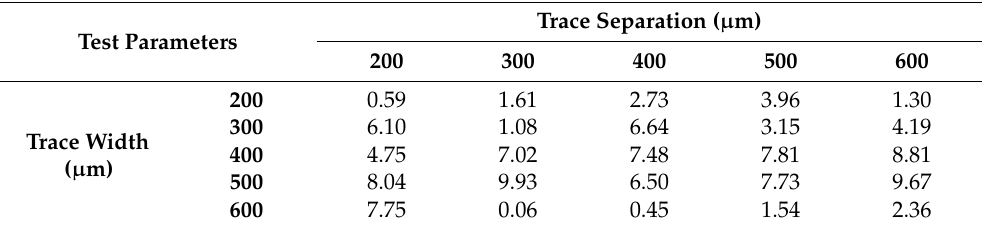
Table 7. The percentage error between the numerically calculated and measured inductances of elliptical planar inductors after using the proposed model for different combinations of trace separation ( S ) and trace width ( W ) while major-to-minor ratio ( R ) = 3 and number of turns ( N ) = 5. % Error in Calculated and Measured Values (Number of Turns ( N ) = 5, Major-to-minor ratio